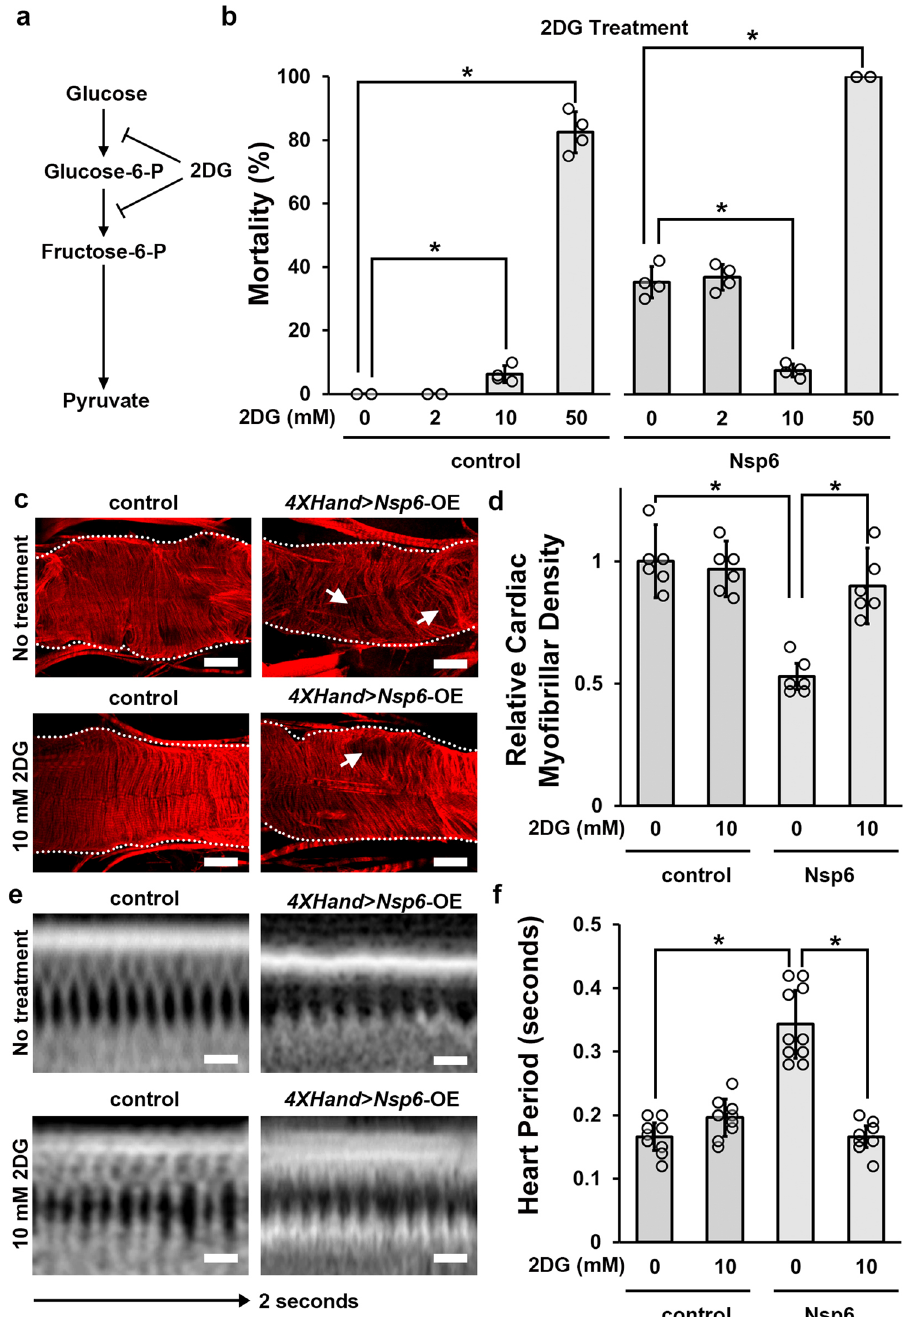
Fig. 5 Inhibiting glycolysis activity by 2DG attenuates SARS-CoV-2 Nsp6 -induced heart morphological and functional defects. a Key metabolites in the glycolysis pathway, with the conversion steps inhibited by 2-deoxy-D-glucose (2DG) indicated. b Quantitation of mortality rate prior to eclosion induced by cardioblast-speci fi c (4X Hand -Gal4 driver) overexpression of the UAS- SARS-CoV-2 Nsp6 transgene, or wild-type ( w 1118 ) control, following different doses of 2DG. Mortality was calculated as (CyO wing − straight wing)/CyO wing × 100. P value (control 0 – 10 mM) = 0.05; (control 0 – 50 mM) = 0.002; (Nsp6 0 – 10 mM) = 0.05; (Nsp6 0 – 50 mM) = 0.0003. n = 4 repeats (~50 fl ies/vial). c Adult heart phenotype induced by cardioblast-speci fi c (4X Hand -Gal4 driver) overexpression (OE) of the UAS- SARS-CoV-2 Nsp6 transgene, compared to wild-type ( w 1118 ) control, following different doses of 2DG. Cardiac actin myo fi bers were visualized by phalloidin staining. Dotted lines delineate the outline of the heart tube. Arrow points to missing cardiac myo fi bers. Scale bars (all) = 40 μ m. d Quantitation of adult heart cardiac myo fi brillar density (in b ) relative to control. P value (0 mM control-Nsp6) = 0.0006; (Nsp6 0 – 10 mM) = 0.03. n = 6 fl ies per genotype. e Drosophila heartbeat video images from fl ies carrying cardioblast-speci fi c (4X Hand -Gal4 driver) overexpression (OE) of the UAS- SARS-CoV-2 Nsp6 transgene, or wild-type ( w 1118 ) control fl ies, following different doses of 2DG. Scale bars (all) = 25 μ m. f Quantitation of heart period (in d ). P value (0 mM control-Nsp6) = 0.00001; (Nsp6 0 – 10 mM) = 0.00001. n = 10 fl ies per genotype. Statistical signi fi cance (*) de fi ned as P < 0.05 (Kruskal – Wallis H-test followed by Dunn ’ s test); data shown as mean ± SD.